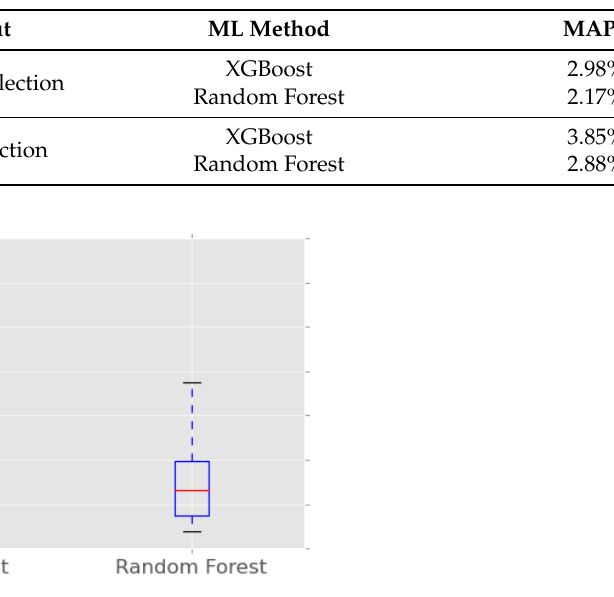
Figure 9. MAPE with feature selection.